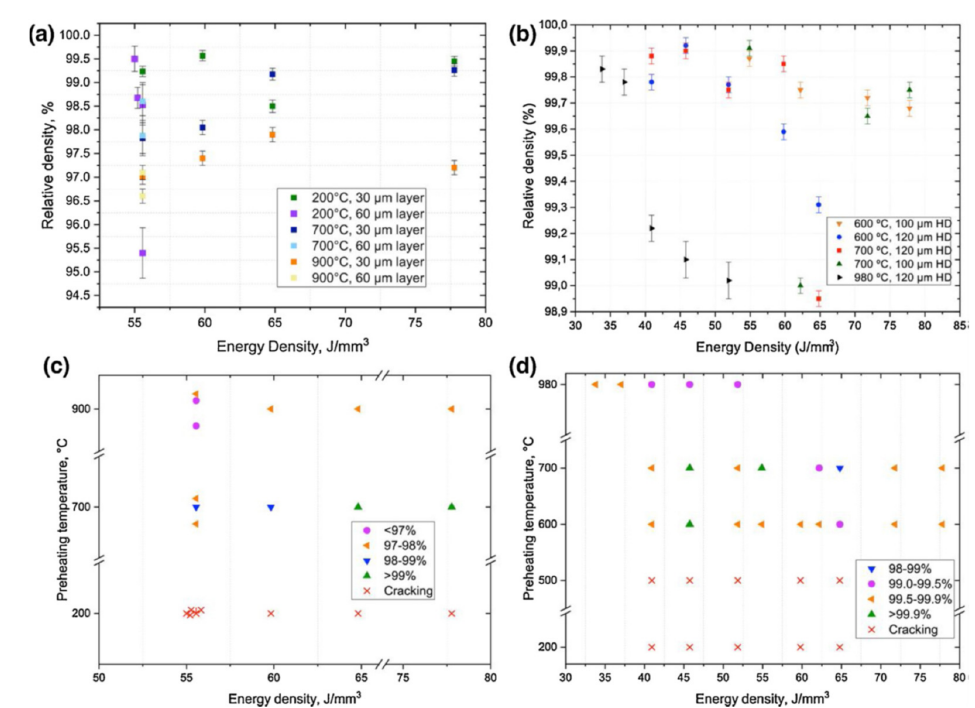
Figure 2. Relative density as a function of volume energy density and preheat substrate temperature for laser-processed samples from ( a ) mechanically alloyed plasma spheroidized (MAPS) and ( b ) gas atomized (GA) powders; and process maps relating preheating temperature of substrate and volume energy density for the samples from ( c ) MAPS and ( d ) GA powders. Reprinted with permission from ref. [86]. Copyright 2021